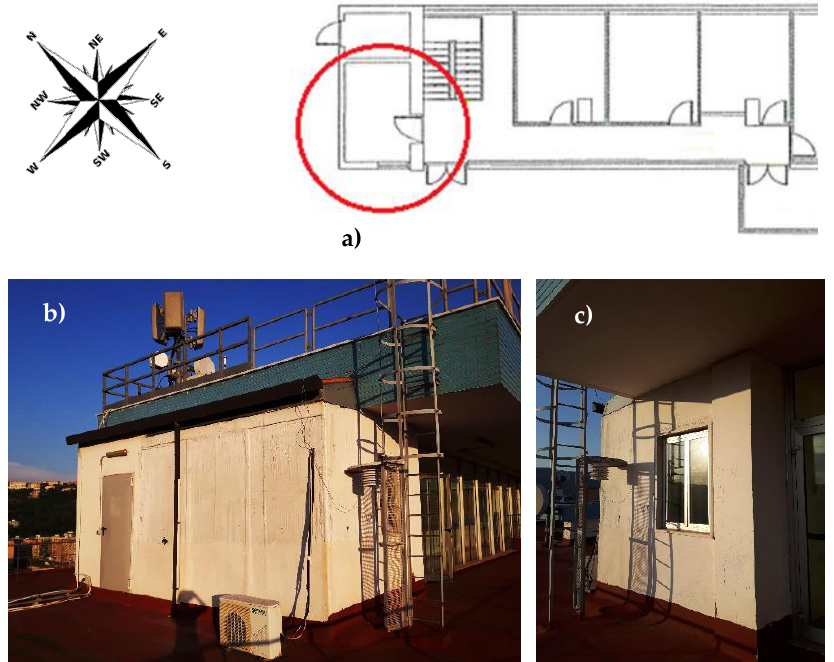
Figure 3 . Test-cell sketch: a ) plant and orientation; b ) North-West view; c ) South-West view. Figure 3. Test-cell sketch: ( a ) plant and orientation; ( b ) North-West view; ( c ) South-West view.